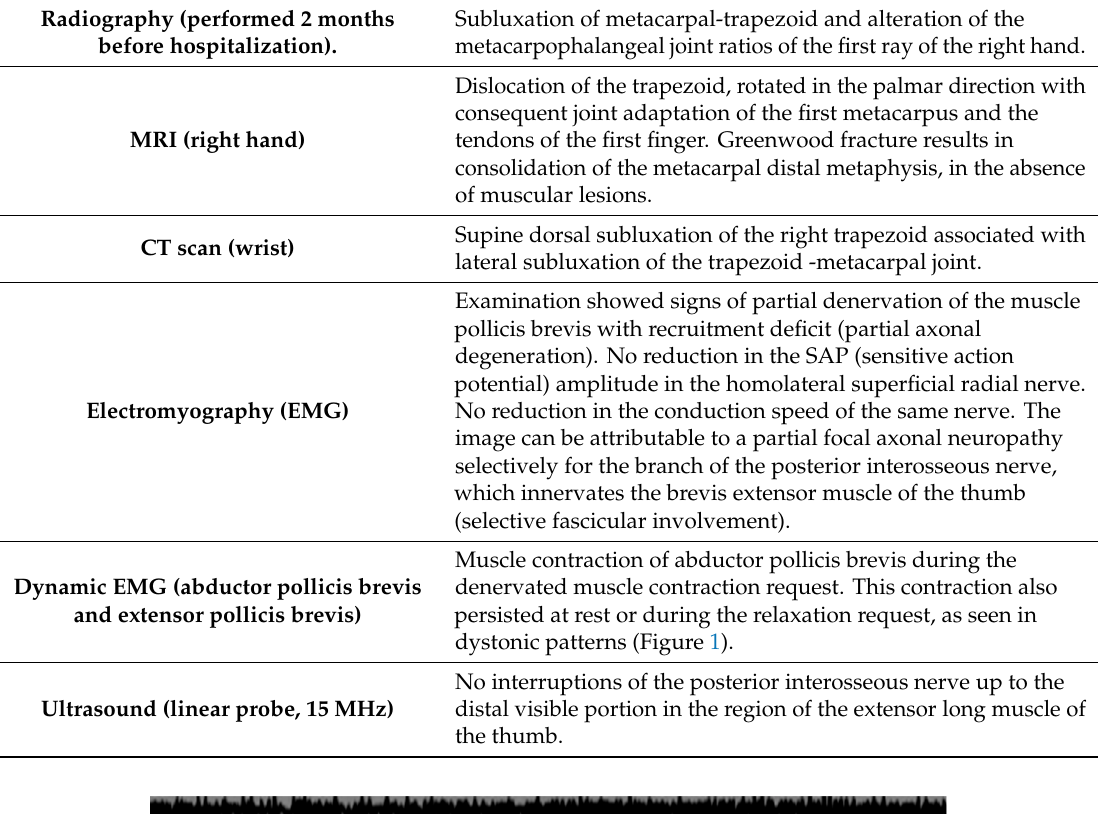
Table 1. Instrumental diagnostic examination performed in patient.